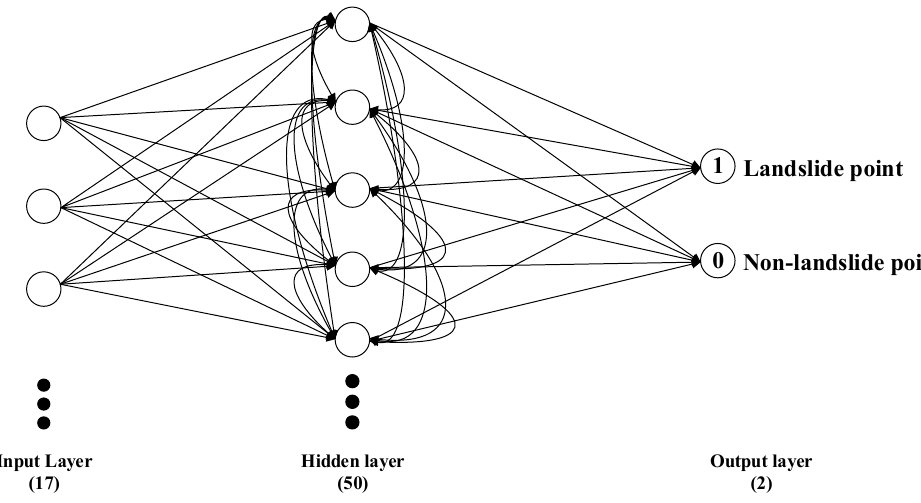
Figure 7. Structure of the constructed RNN model.